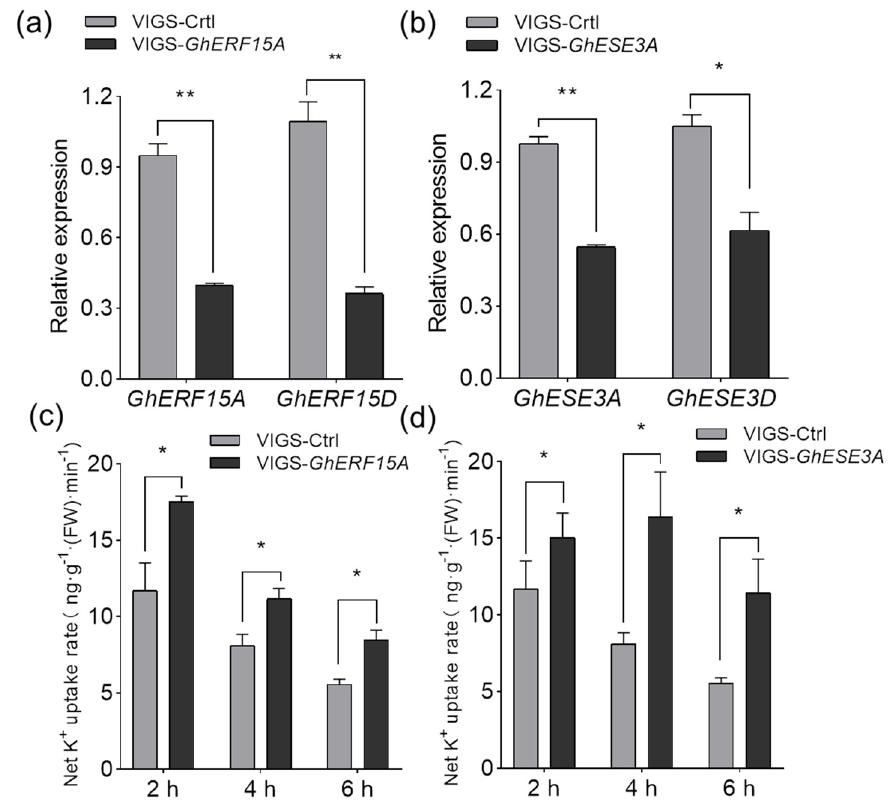
Figure 8. Two members of ethylene response factor (ERF) TFs, GhERF15 and GhESE3 , negatively regulate potassium (K + ) uptake in cotton roots. GhERF15 and GhESE3 were silenced in the variety SCRC22 using agrobacterium-mediated virus-induced gene silencing (VIGS) at the cotyledonary stage. The relative expression of GhERF15 ( a ) and GhESE3 ( b ) indicates that they were silenced in both A and D subgenome. The seedlings at three-leaf stage were moved into K + -starvation solutions for 48 h, then transferred to measuring solution with 0.08 mM K + to determine the net K + uptake rate ( c , d ). * and ** indicate significant differences at 5% and 1% level,